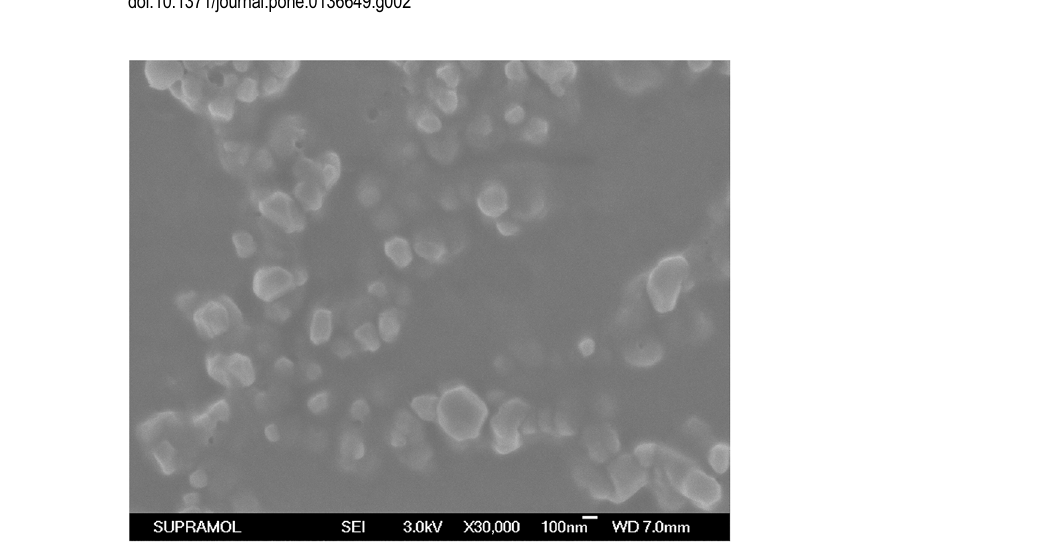
Fig 3. FE-SEM images of Tf-LP-Compound